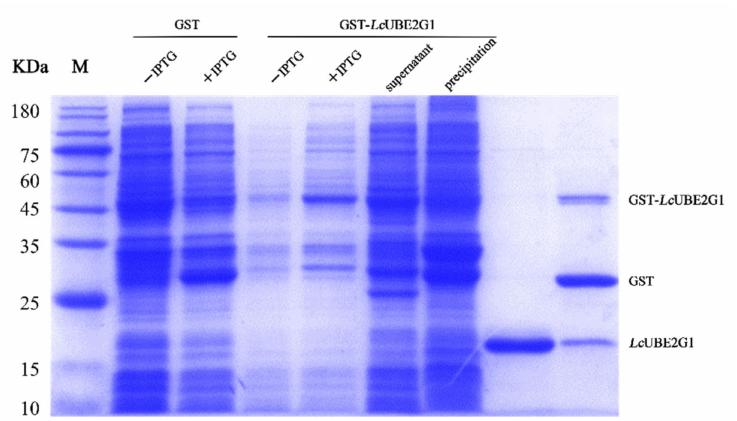
Figure 5. SDS-PAGE analysis of recombinant Lc UBE2G1 fusion